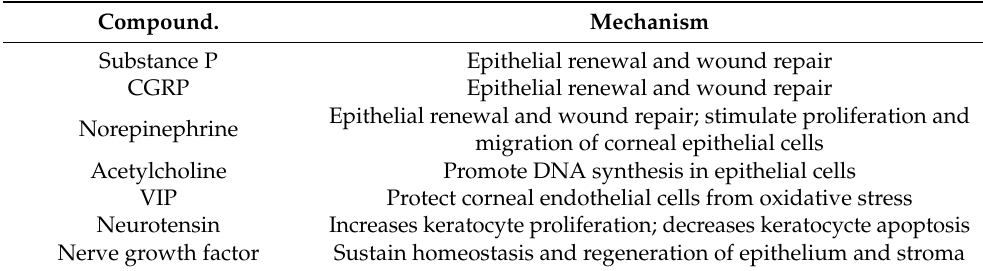
Table 1. Various peptide and transmitters in the cornea of mammals. Compound. Mechanism Substance